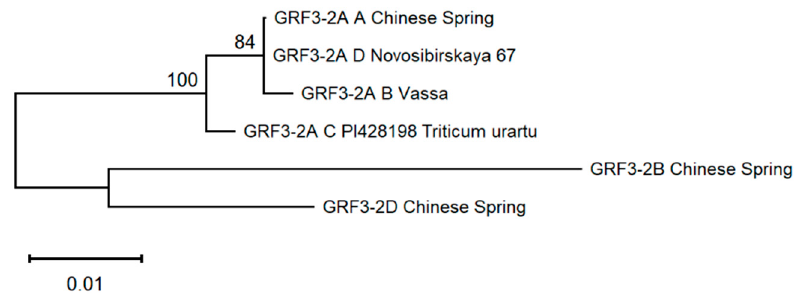
Figure 2. Molecular phylogenetic tree of GRF3-2A protein isoforms. GRF3-2B and GRF3-2D proteins of Chinese Spring were taken as outgroups.